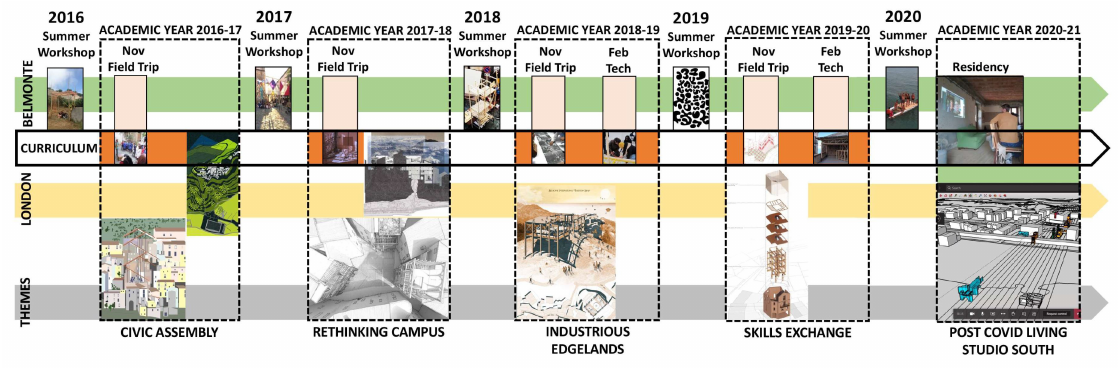
Figure 1. Academic structure with curriculum and voluntary activities, 2016–21 (Source: author)